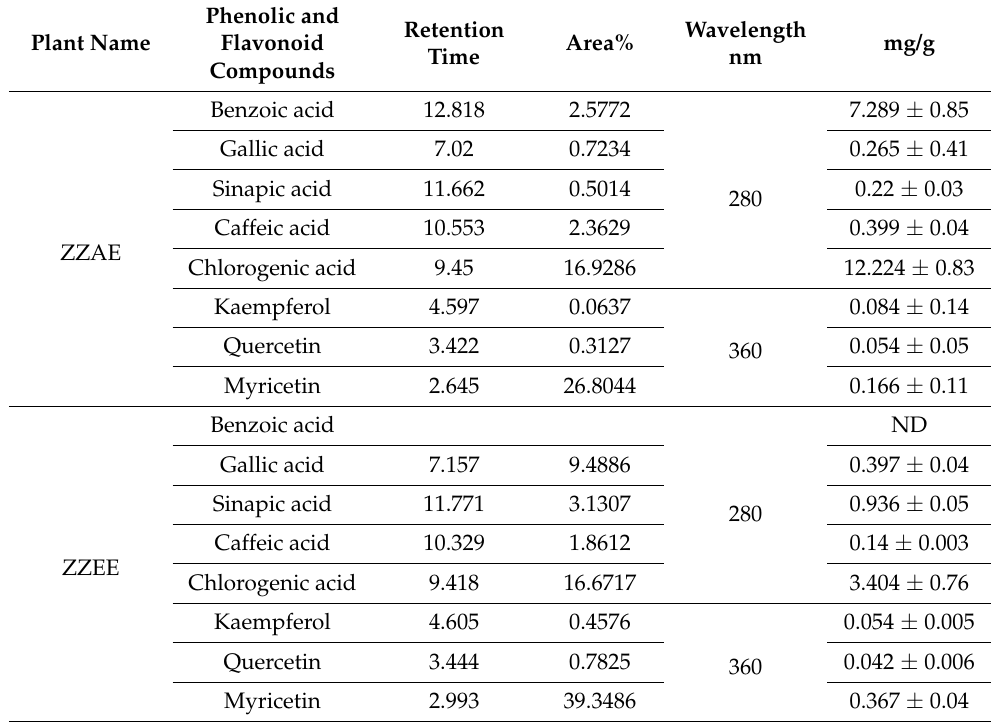
Table 2. Flavonoid and phenolic contents in the Z. zerumbet rhizome extract, determined by the HPLC methods.